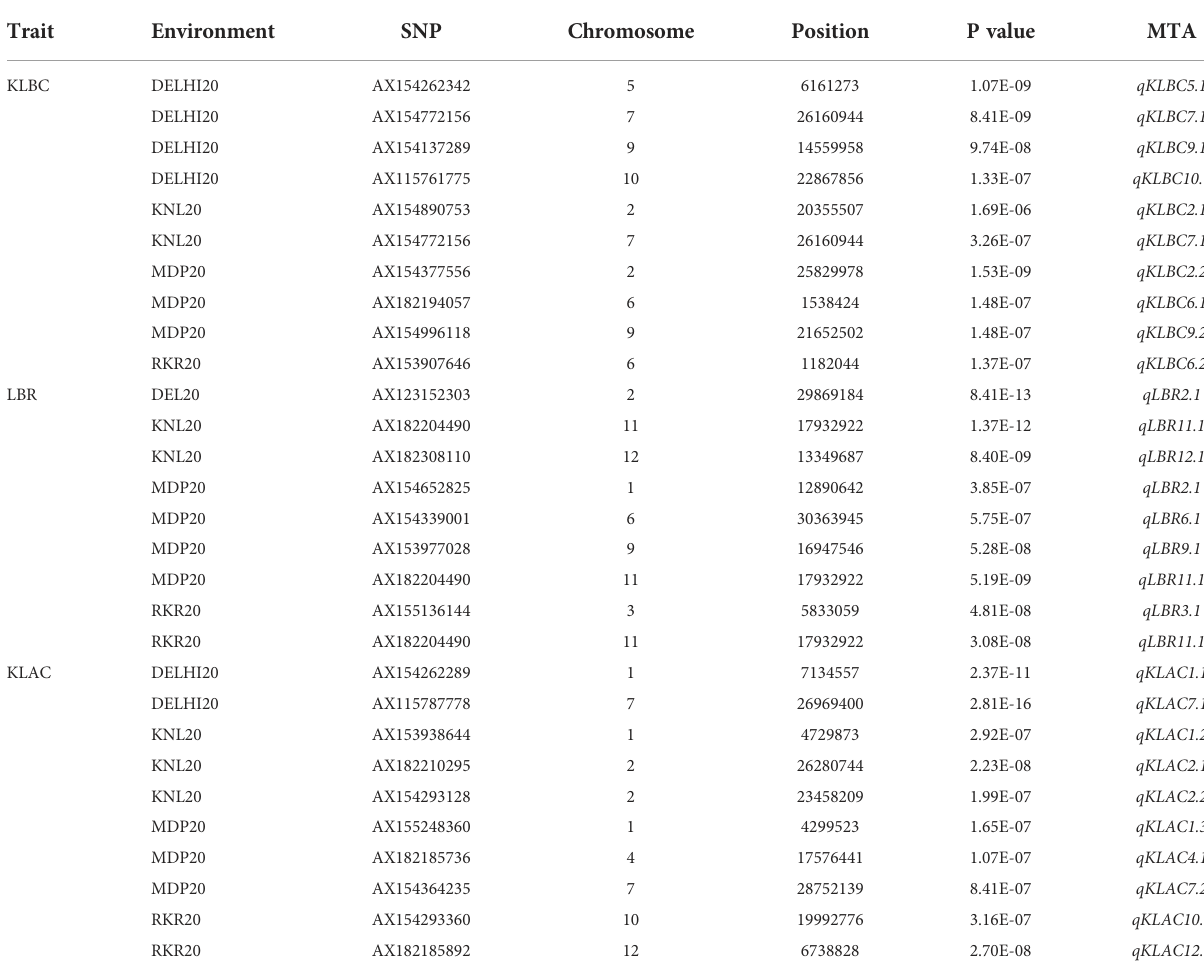
TABLE 4 Marker trait associations (MTA) detected in GWAS by using the BLINK model for the grain quality traits in four environments.